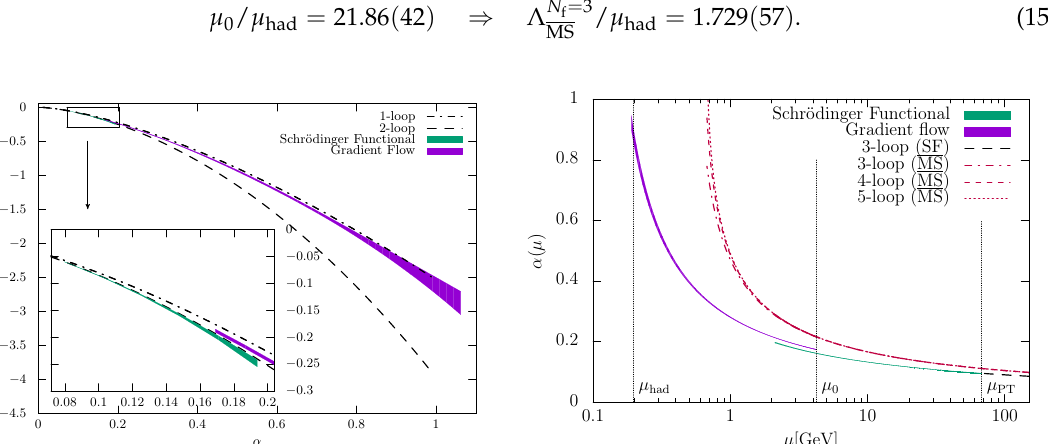
Figure 4. ( Left ): Non-perturbative β -functions in the GF and SF ( ν = 0 ) schemes determined in refs. [5] and [4,7], respectively. ( Right ): Running couplings of N f = 3 QCD obtained from Λ N f = 3 the non-perturbative β -functions